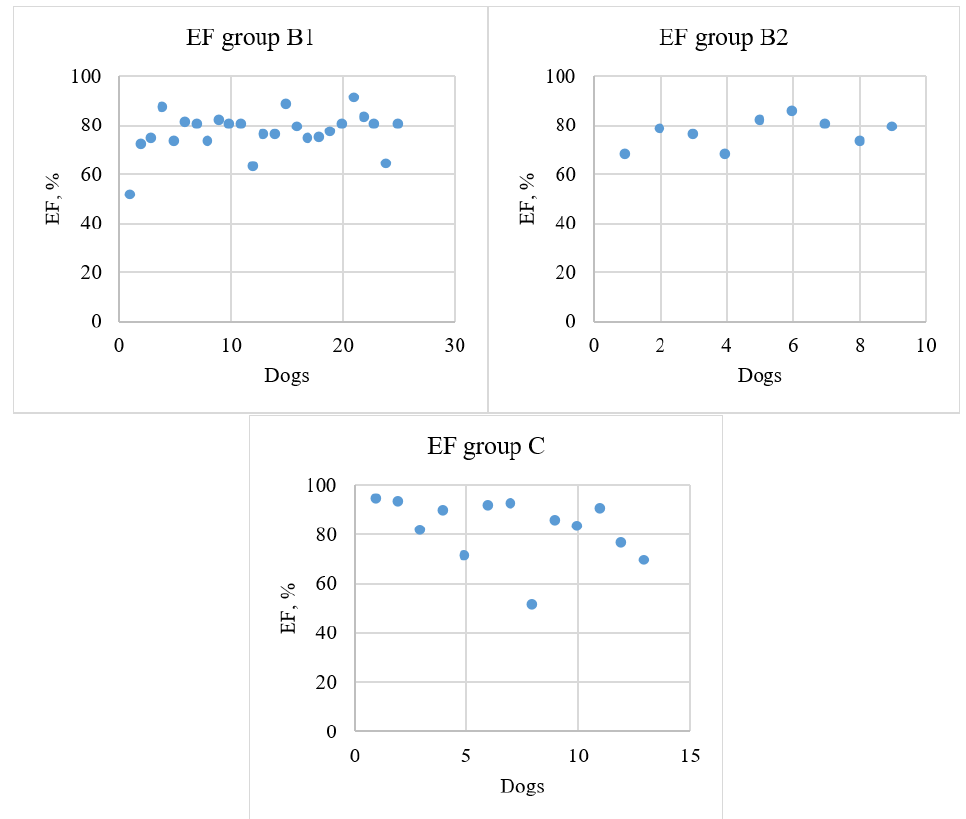
Fig. 4 . Spot diagram of the EF values of experimental animals with the progression of